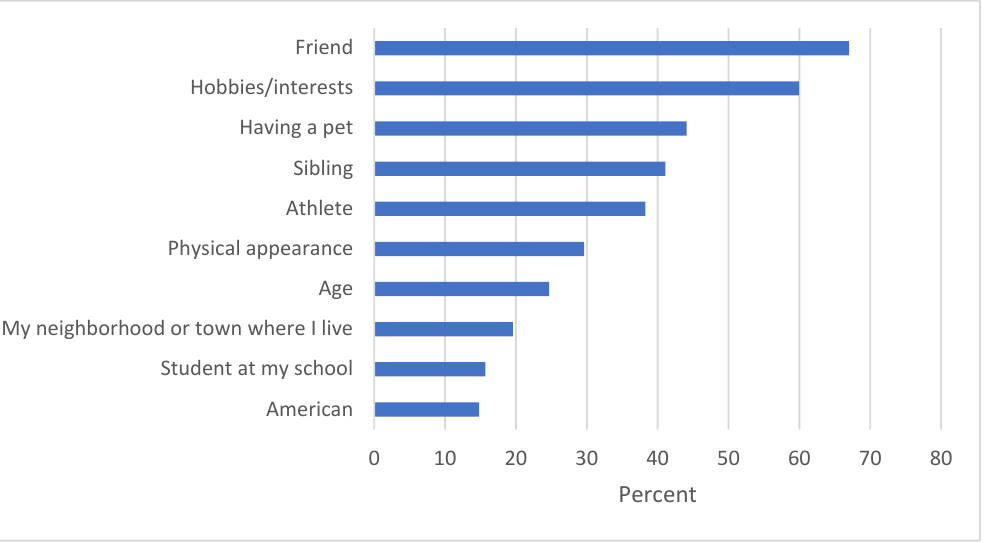
Figure 1. Most important social identities (or ways of defining themselves) selected by pet owners.